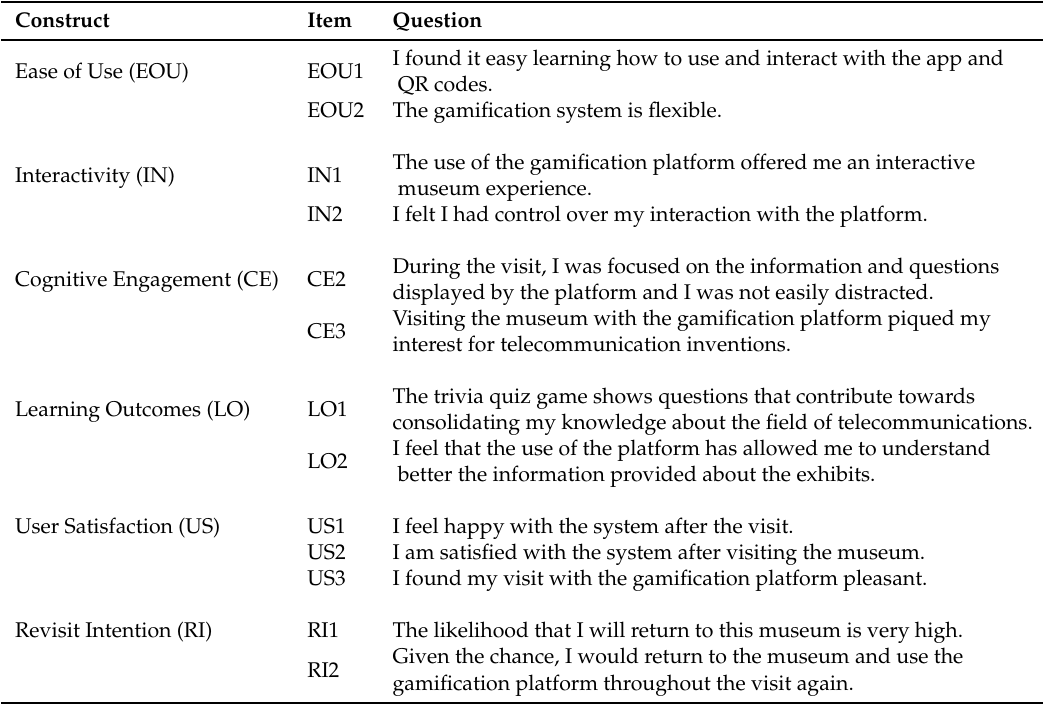
Table 3. Constructs and items of the measurement